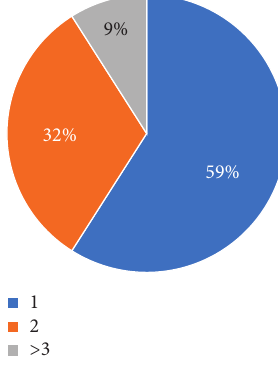
Figure 3: Number of bays in industrial